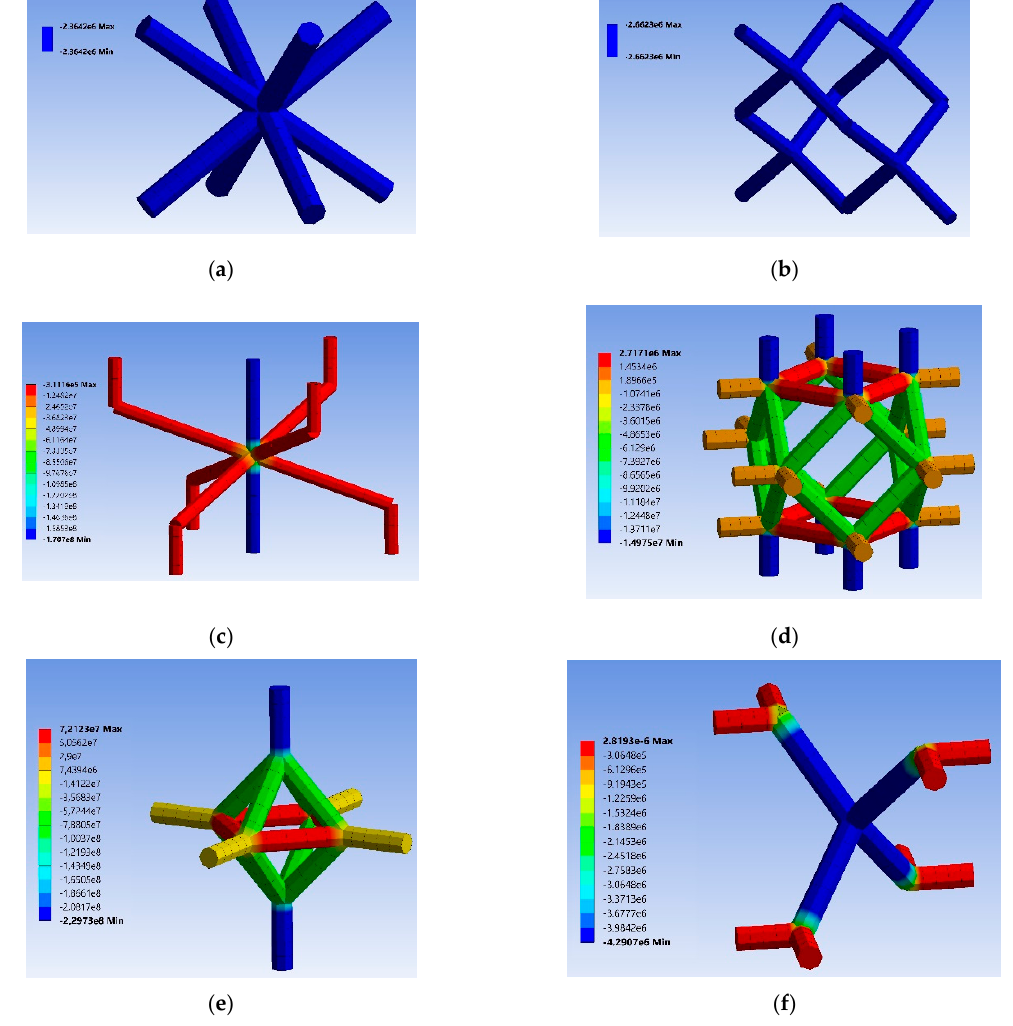
Figure A3. Axial stress of unit cells: ( a ) BCC; ( b ) diamond; ( c ) hexagonal packing; ( d ) rhombicuboctahedron; ( e ) truncated cube; and ( f ) truncated octahedron in ANSYS.